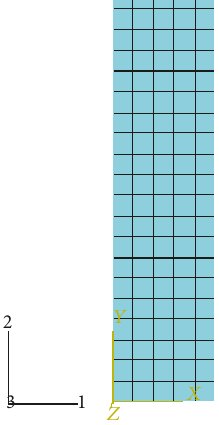
Figure 3: Finite element model of concrete